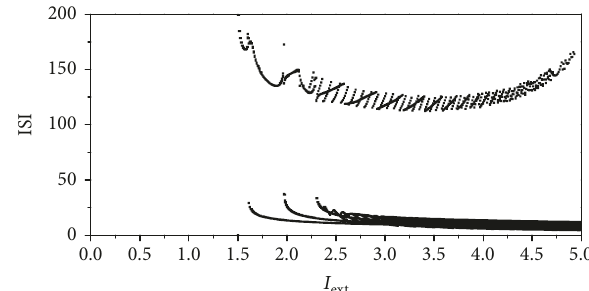
Figure 1: Bifurcation diagram with the increasing of external direct current 𝐼 ext